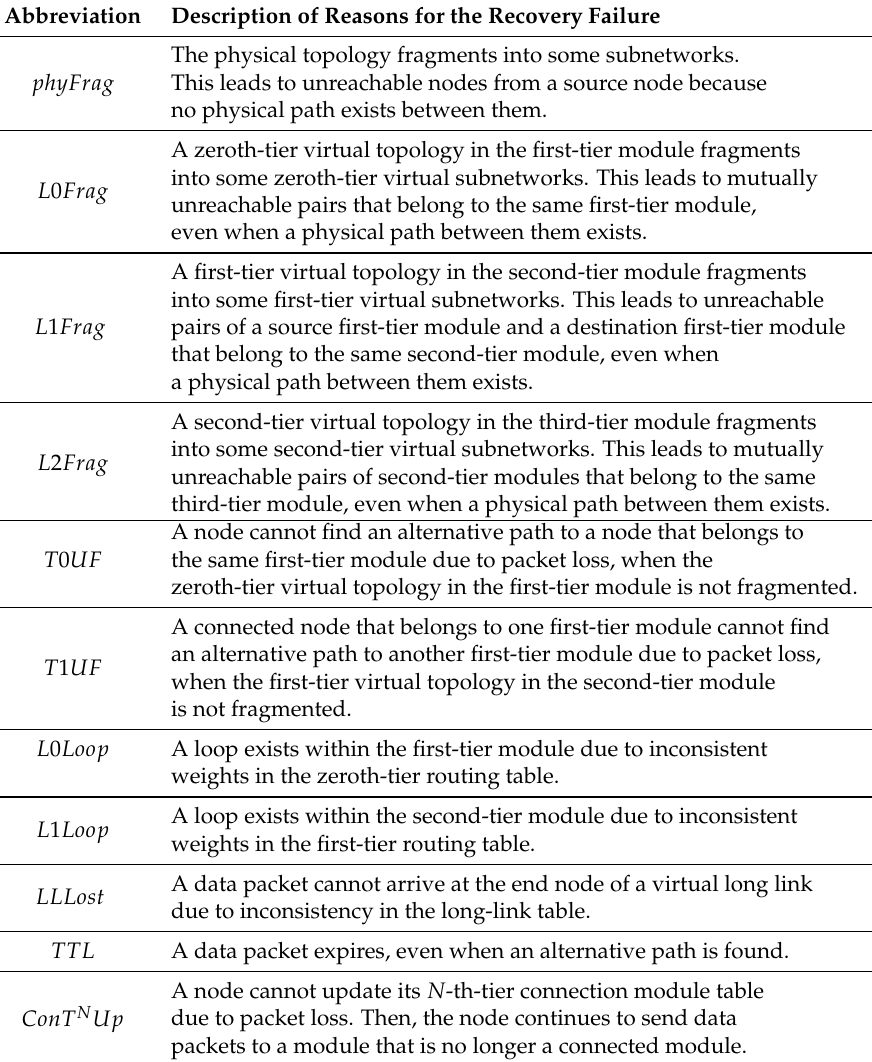
Figure 4. Physical topology and the result of modular division by the Newman algorithm. Table 2. List of reasons for the failure to recover the data delivery